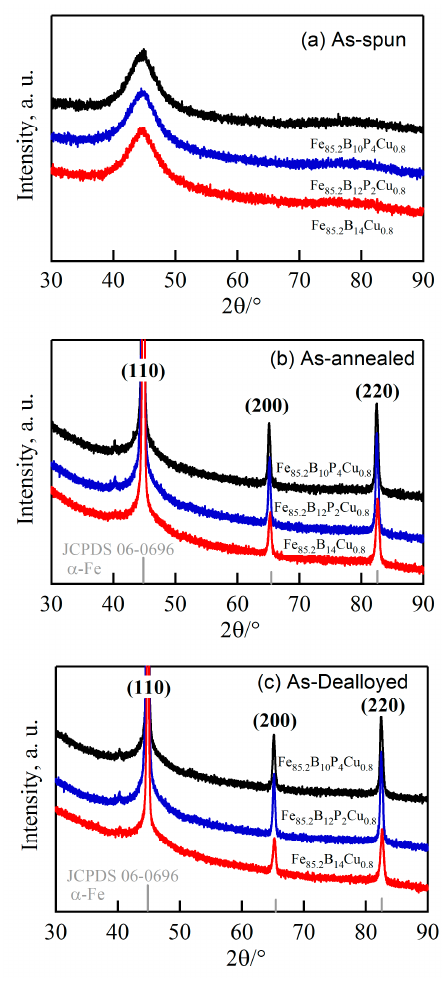
Figure 1. X-ray diffractometor (XRD) patterns of as-quenched amorphous ( a ) as-annealed nanocrystalline ( b ) and as-dealloyed nanoporous ( c ) Fe 85.2 B 14 − x P x Cu 0.8 alloys ( x = 0, 2, 4 at.%) alloys.